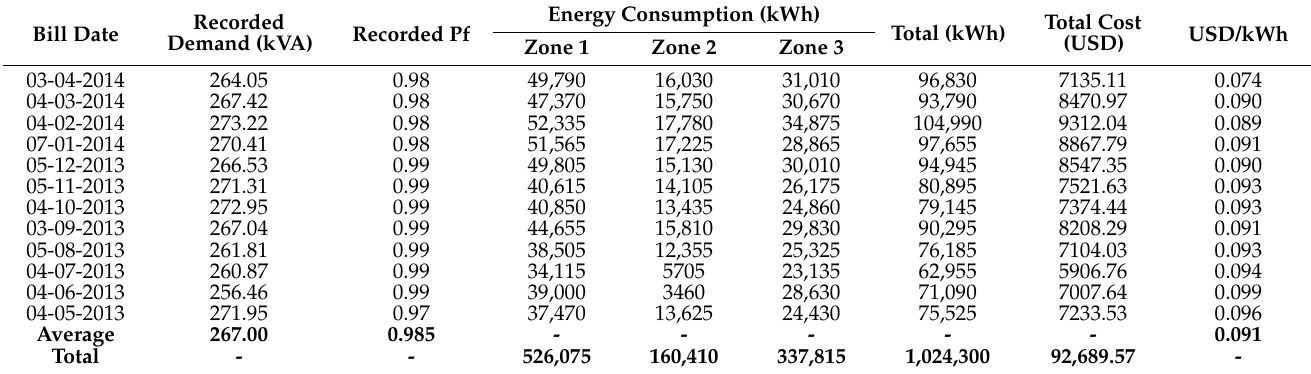
Table 5. Electrical bill analysis.